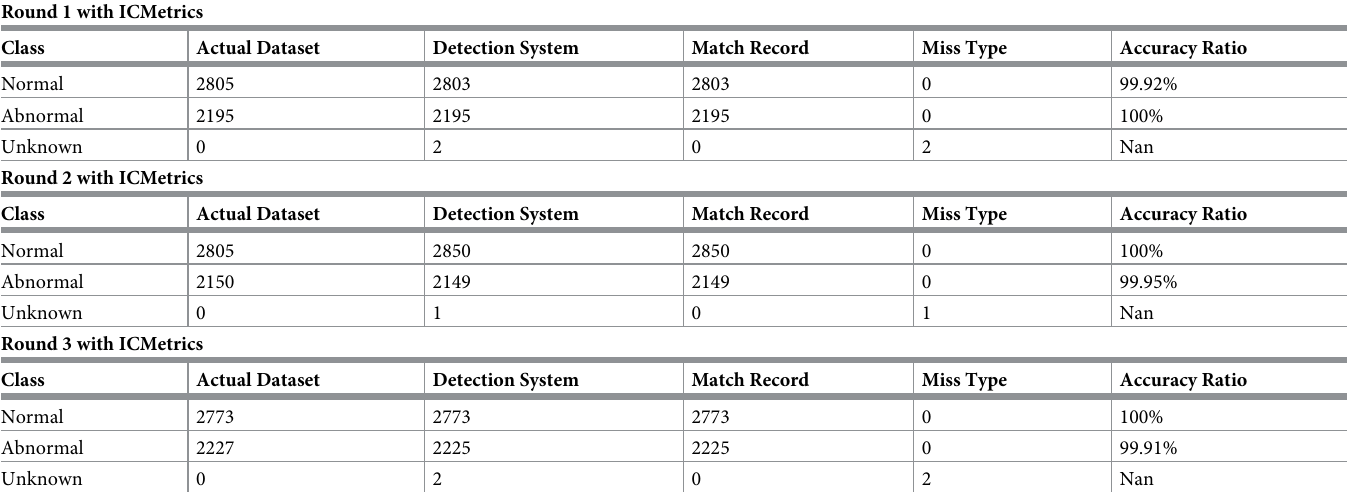
Table 4. Classification accuracy rate with ICMetric.